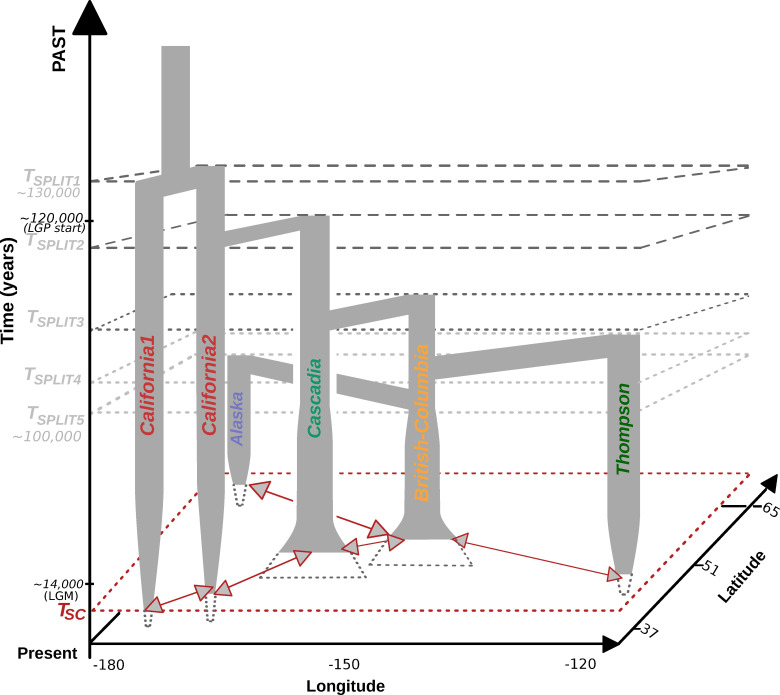
Simplified spatio temporal representation of the coho salmon demographic history based on ∂a∂i and Fastsimcoal results.Each bar represents a population branch. the width of the branch is not proportional to the population effective size and do not account for historical population size changes. The split time are not to scale and geographic positions are approximate. Tsc = Time of secondary contact. Red arrows represents major gene flow events between neighboring populations. Details about gene flow event can be found in S5 Table and S7 Table. LGP = approximate start time of the Last Glacial Period [96]. LGM = Last Glacial Maxima Beringia was unglaciated during most of the pleistocene [97]. See results for details of the grouping.